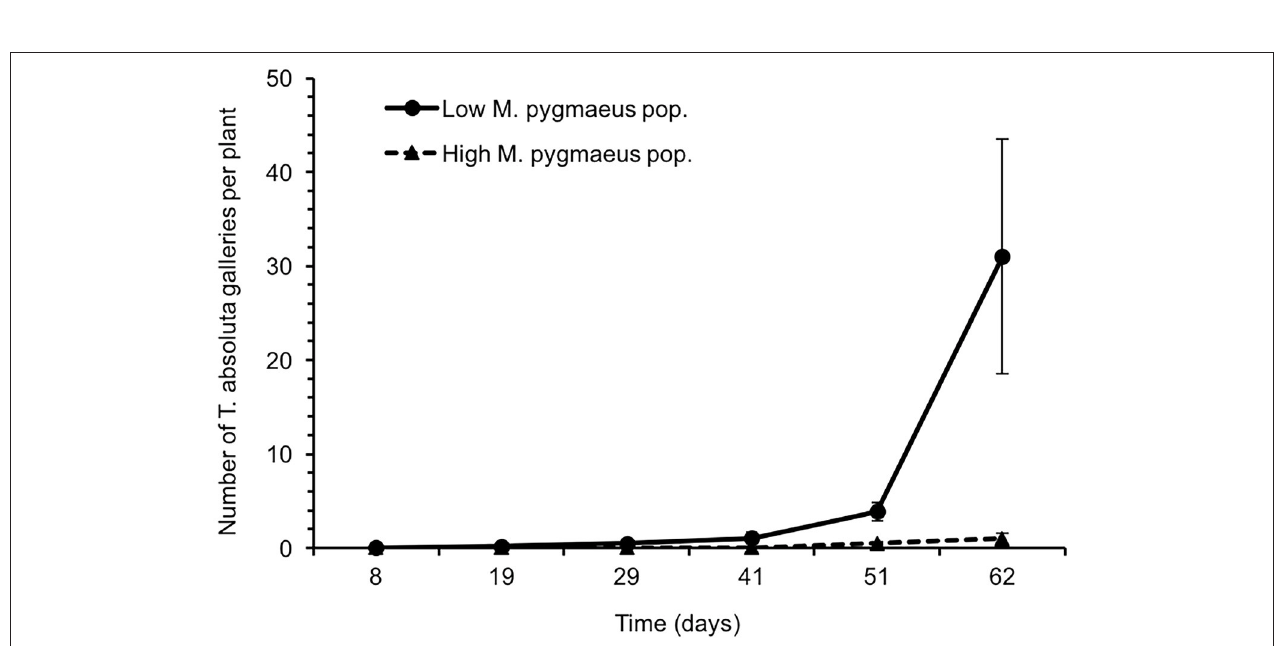
FIGURE 2 | Average number of Tuta absoluta galleries ± SE per tomato plant in greenhouses with low and high M. pygmaeus populations. Time since the introduction of Bemisia tabaci .